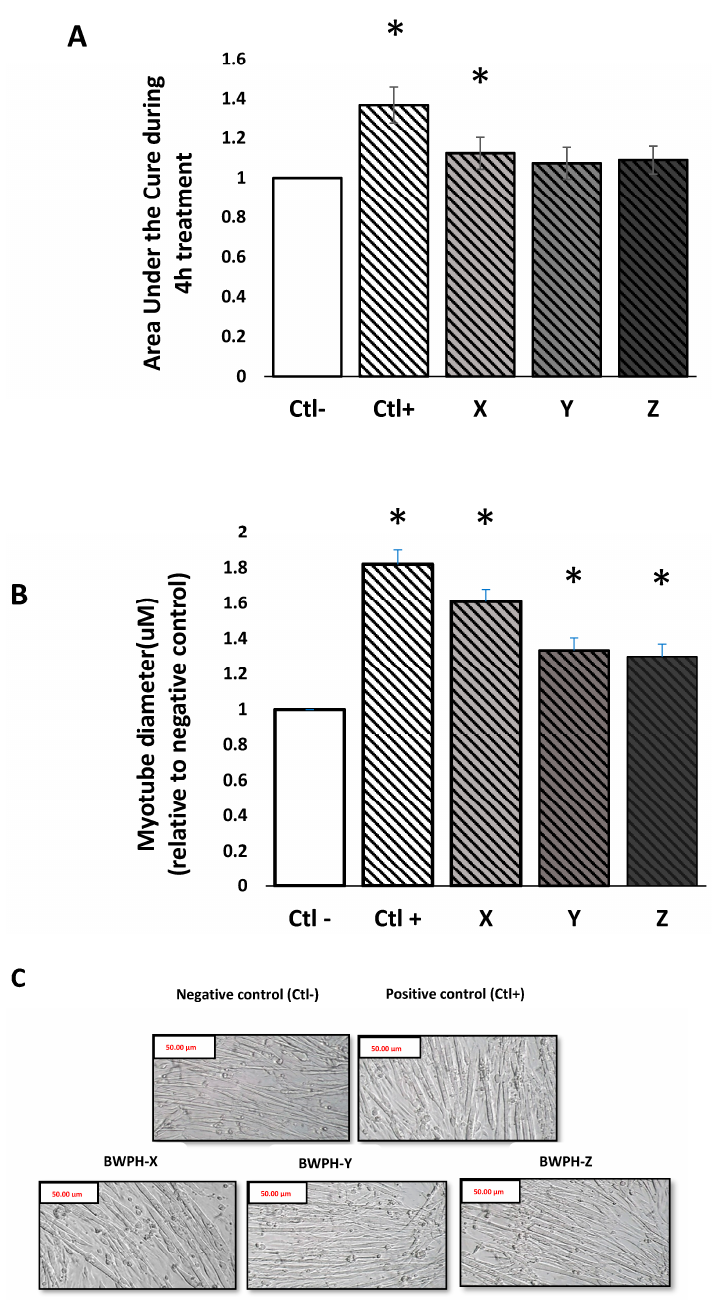
Figure 2. Effect of blue whiting ( Micromesistius poutassou ) protein hydrolysate (BWPH) treatment on AUC and myotube diameter in skeletal muscle cells. C2C12 myotubes were nutrient deprived for 1 h followed by 4 h treatment with 1 mg·mL − 1 protein equivalent of BWPH-X, Y and Z. Myotube growth was monitored every 2 min over 4 h. ( A ) Representative graph comparing myotube growth (AUC) in the presence of different samples relative to the negative control. ( B ) Representative graph comparing myotube diameter in the presence of different samples relative to the negative control ( C ) Quantification of myotube diameter taken 4 h post treatment as measured by microscopy. Images of myotubes treated with samples were taken at 4 × magnification following 4 h treatment. All values are expressed as mean ± SD (n = 6) for 3 plates (duplicate in each plate). p < 0.05 * compared to the negative control (amino acid and serum free media). Ctl − : negative control (amino acid and serum free media), Ctl+: positive control (100 ng · mL − 1 IGF-1), X: SGID-BWPH-X, Y: SGID-BWPH-Y, Z: